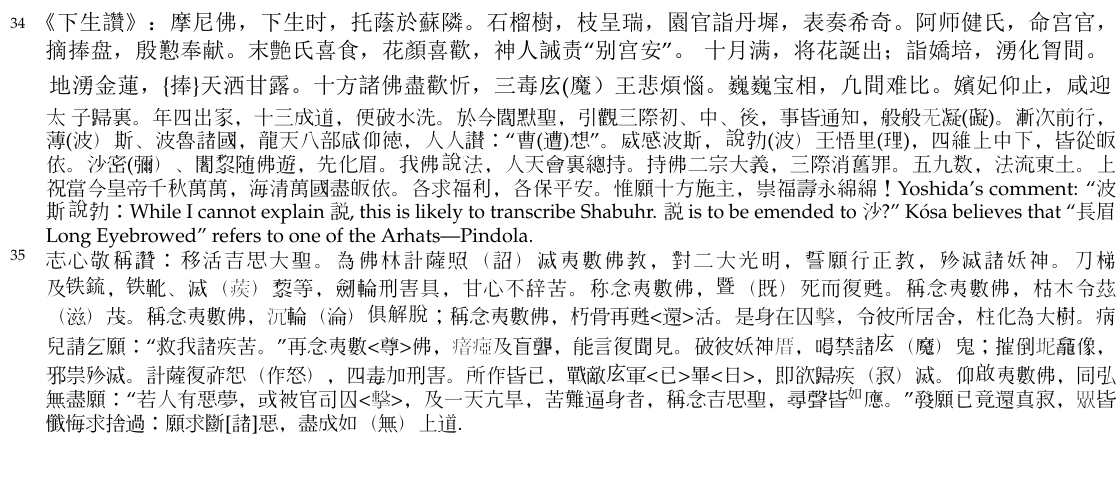
Figure 10. Four Great Venerable Buddhas (Gulácsi 2016, Figure 6/17 [p. 368]). 3.2.14. Rest ( xieshi 歇時 ), Performing Worshipping ( zuo xinli 做信禮 ) (cc.